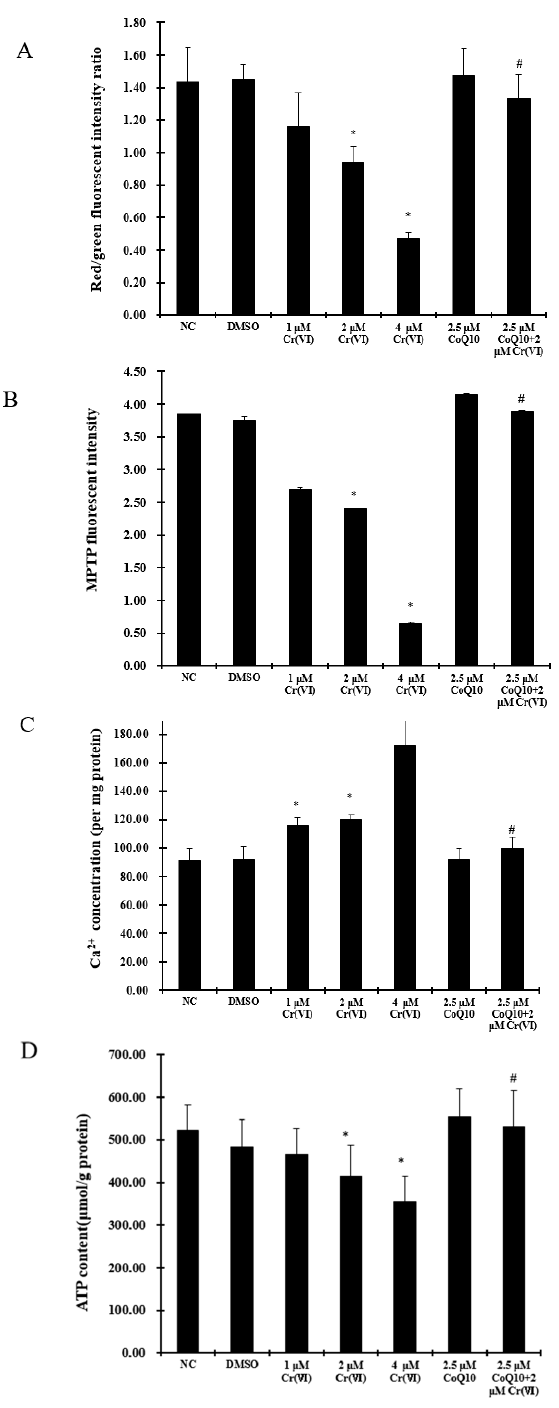
Figure 4. Cr(VI) induces mitochondrial depolarization, MPTP opening, Ca 2+ overload, and ATP level decrease, and these outcomes are attenuated by CoQ10. ( A ) Effect of CoQ10 on Cr(VI)-increased mitochondrial membrane potential in L-02 hepatocytes. The mitochondrial membrane potential was examined by JC-1 staining; ( B ) The activity of MPTP was detected using the calcein-AM-cobalt assay; ( C ) the Ca 2+ concentration was measured with Flo-3M by fluorescence spectrophotometry; ( D ) cells were treated with Cr(VI) (0–4 µ M) for 24 h, with or without CoQ10 pretreatment for 2 h, and the ATP levels in L-02 hepatocytes were assessed. The data are presented as mean ± SD ( n = 6). * p < 0.05 compared with the control group; # p < 0.05 compared with the 2 µ M Cr(VI) treatment